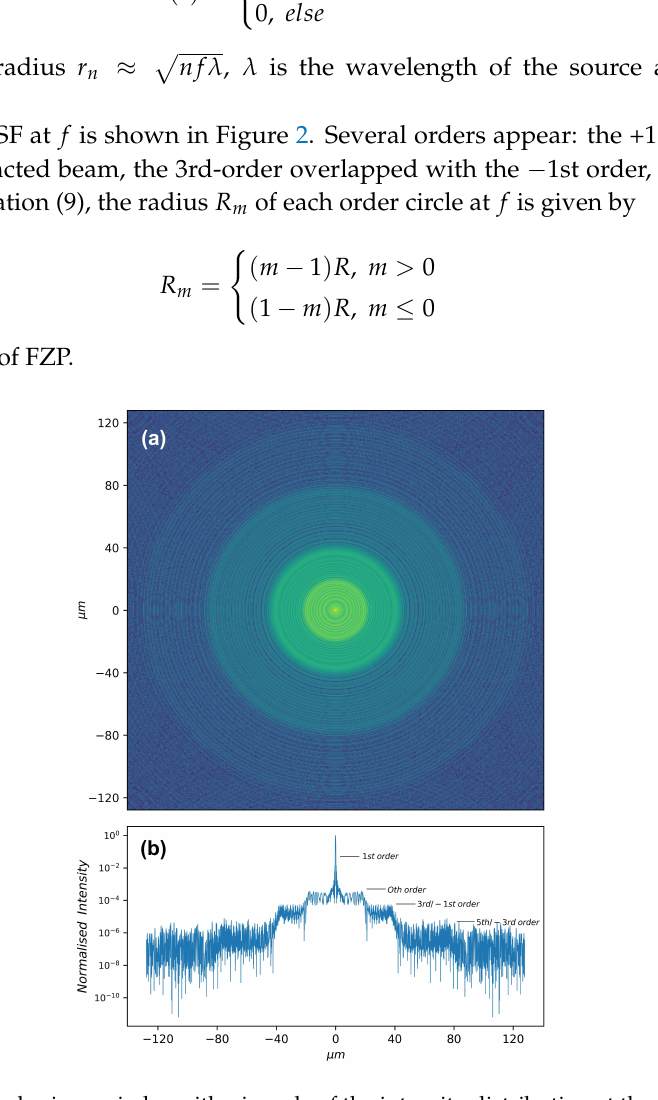
Figure 2. ( a ) False color image in logarithmic scale of the intensity distribution at the first focal plane of a FZP. The parameters of the FZP are focal length f = 8.98 cm, radius r = 20 µ m, and number of zones N = 40. The point source was set at an energy of 11 keV and situated at 100 f prior the FZP. ( b ) Central row intensity profile of panel (a): the radii of 0th order, 3rd/ − 1st order, and 5th/ − 3rd order are, respectively, 20 µ m, 40 µ m, and 80 µ